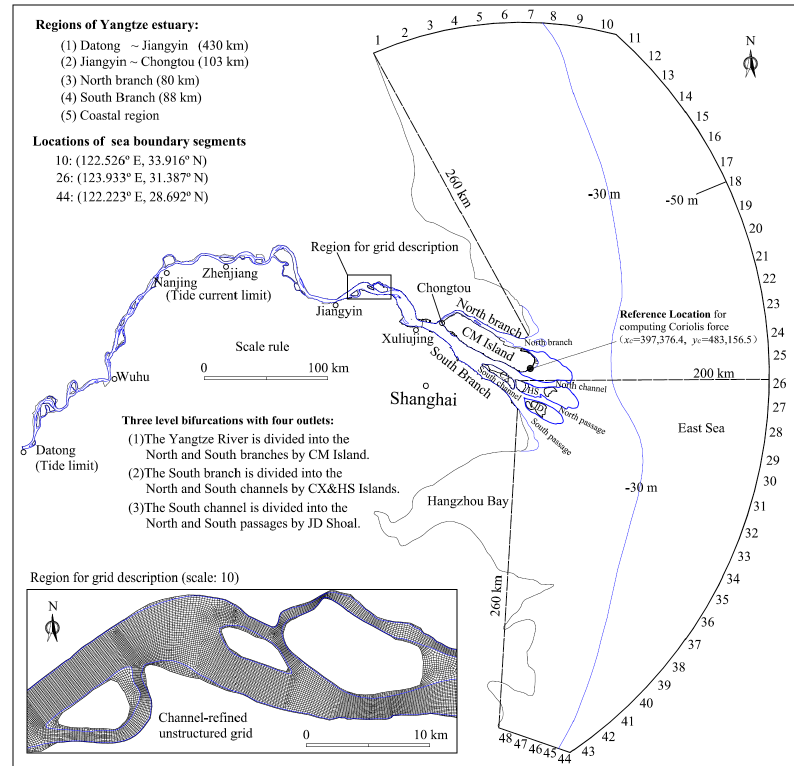
Figure 2. Description of the bound, the three-level bifurcations and the strong